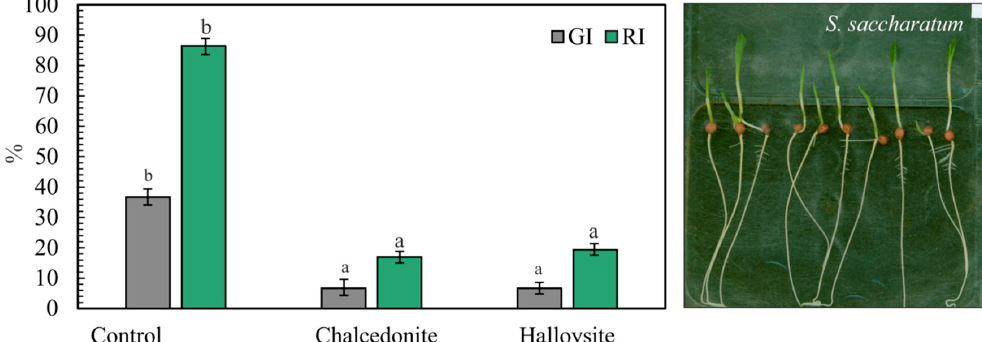
Figure 8. Growth inhibition (GI) and root growth (RI) of S. saccharatum before the phytostabilization experiment. Error bars represent standard deviation error (SD, n = 6 determinations). Different letters denote significant differences between treatments.